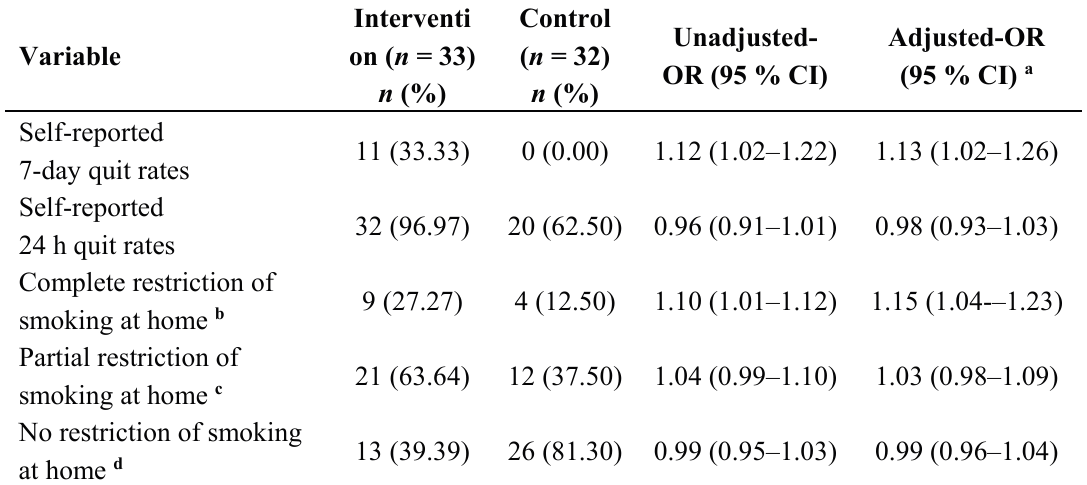
Table 3. Unadjusted and adjusted odds ratios (ORs) for quitting outcomes using different outcome indicators in the intervention and control groups at the 6-month follow-up.